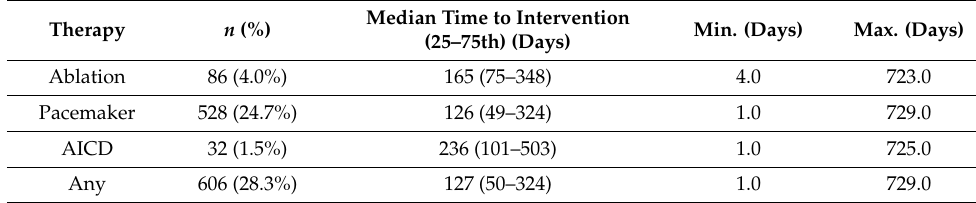
Table 1. Resultant therapy after ICM